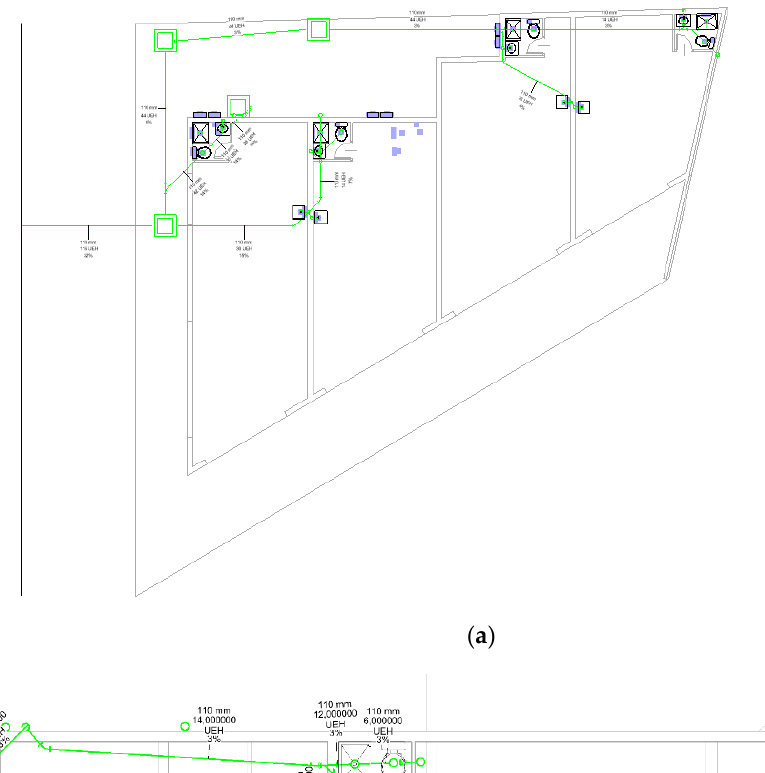
Figure 16. Example of an alert for pipelines that do not comply with the established minimum.